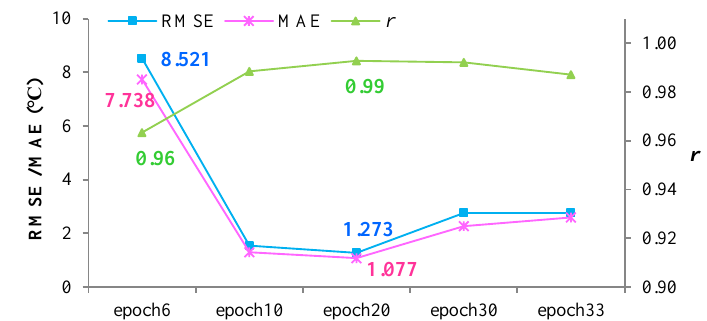
Figure 5. SST prediction for 12 months under different epochs.